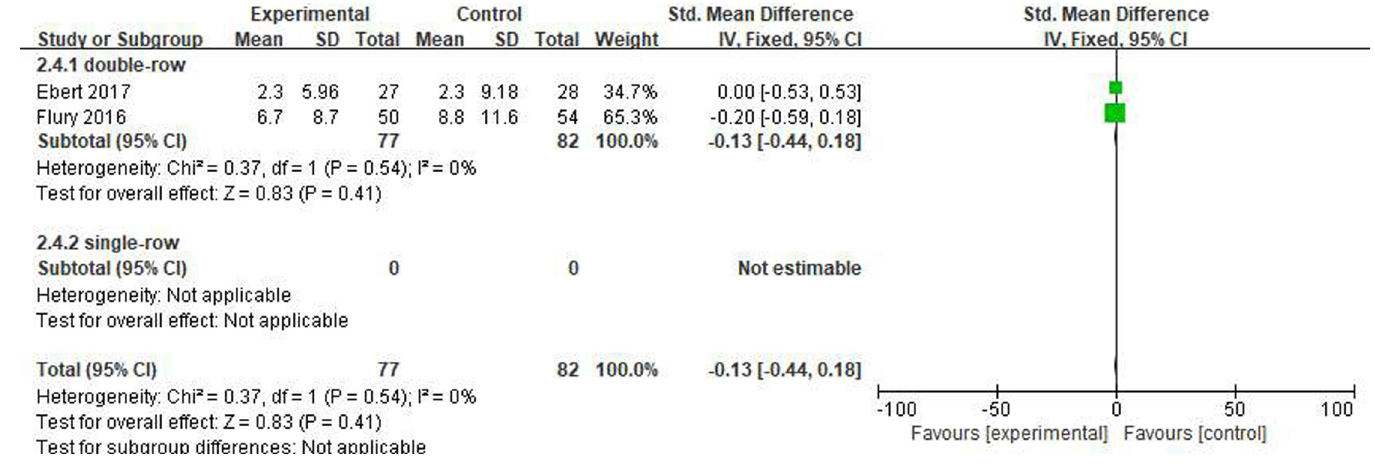
Fig 8. Forest plot for the long-term DASH score.